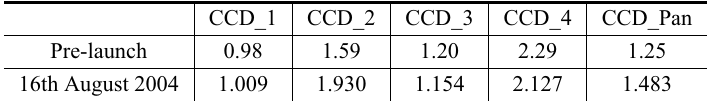
Comparison of the calibration coefficients calculated from pre-launch and the vicarious calibration campaign.